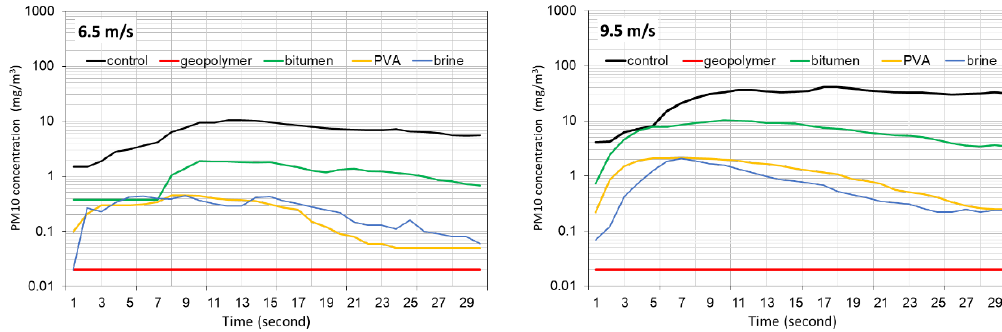
Figure 2. PM10 concentrations recorded during the laboratory wind tunnel experiment on the diverse dust control products under wind velocities 6.5 ( right side) and 9.5 m s −1 ( left side). Note, the “control” is the Loess soil with no treatment. The background level measured in the wind tunnel before the test was ~0.020 mg m −3 .